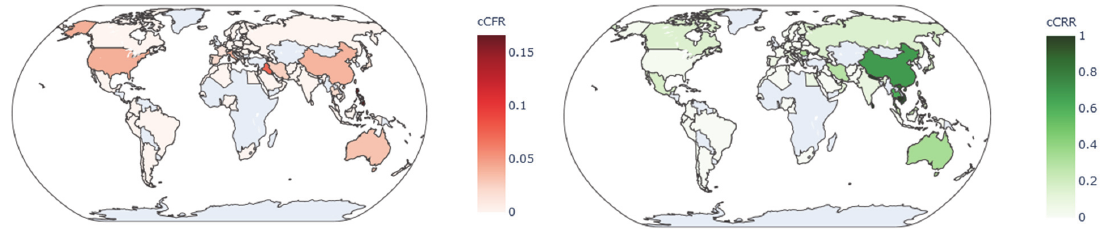
Fig. 3. Global view of cCFR on 7 Mar. 2020 Fig. 4. Global view of cCRR on 7 Mar.